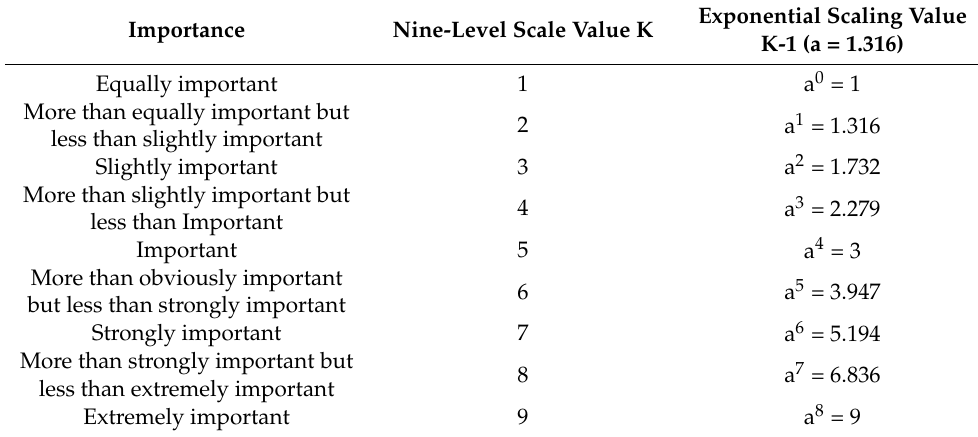
Table 1. The meaning of the exponential scaling